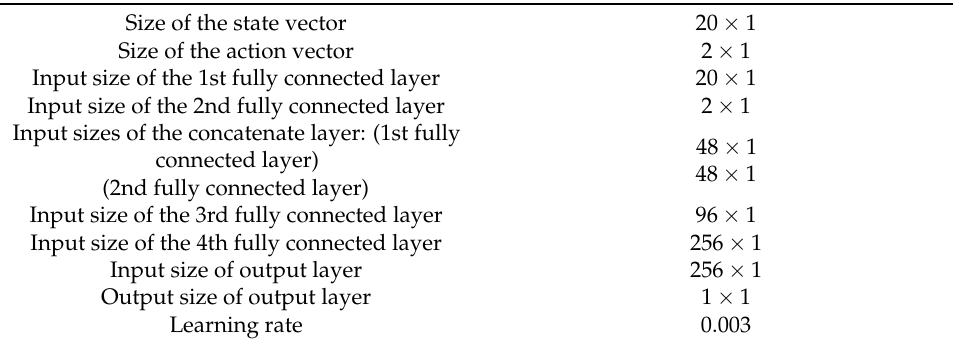
Table 4. Hyperparameter settings of the proposed critic network.